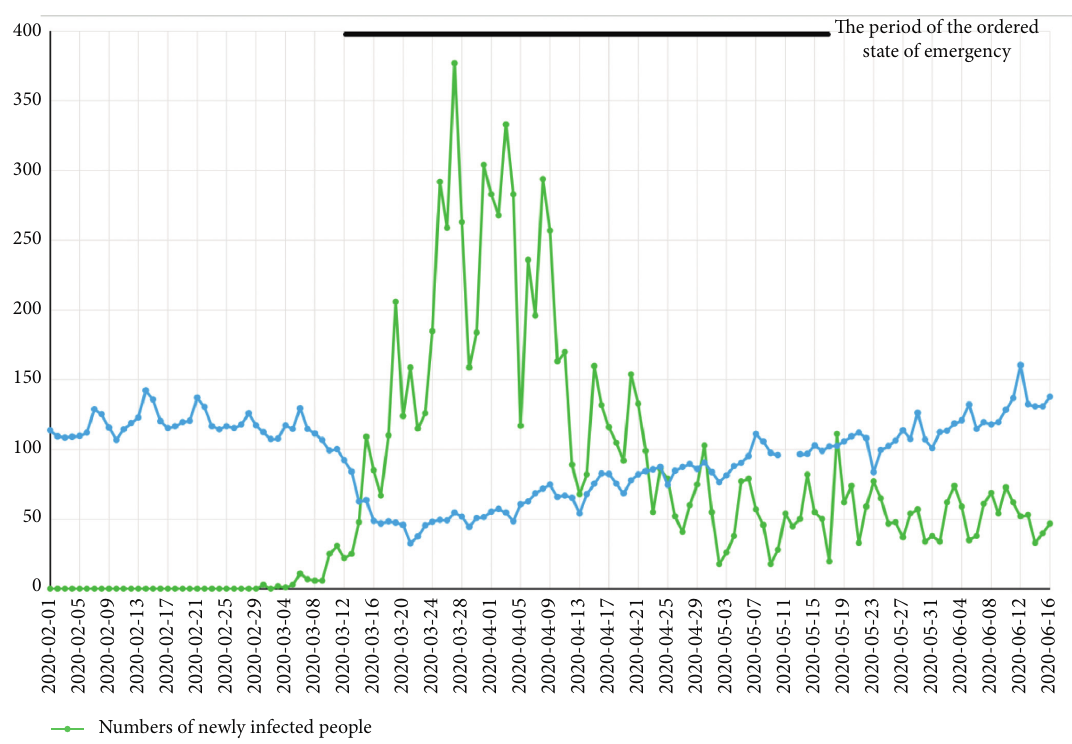
Figure 1: Numbers of newly detected people infected by COVID-19 during the state of emergency and mobility trends according to Apple Maps in the Czech Republic. Source: [9,